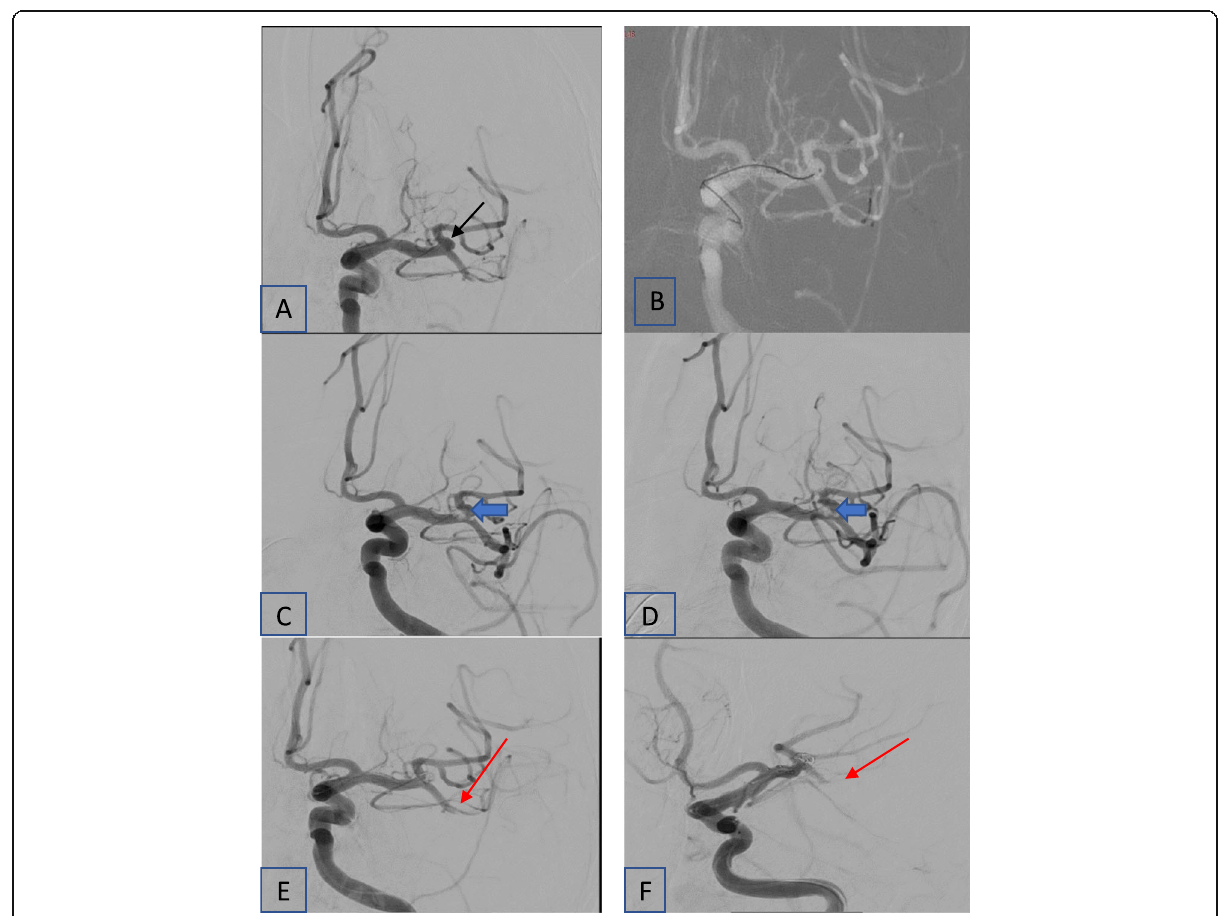
Fig. 6 Thromboembolic complication. Small M1-M2 bifurcation wide neck aneurysm, planned to be treated with T-stenting. A AP angiogram showing the small aneurysm (the black arrow). B During advancement of the micro-catheter. C Noted thrombus dislodgment, the filling defect at the M1 segment (the blue arrow). D Trial of mechanical thrombectomy ended by dislodgment of the thrombus into the inferior M2 branch (amputated branch, red arrow). Patient then developed severe chest infection at the ICU and